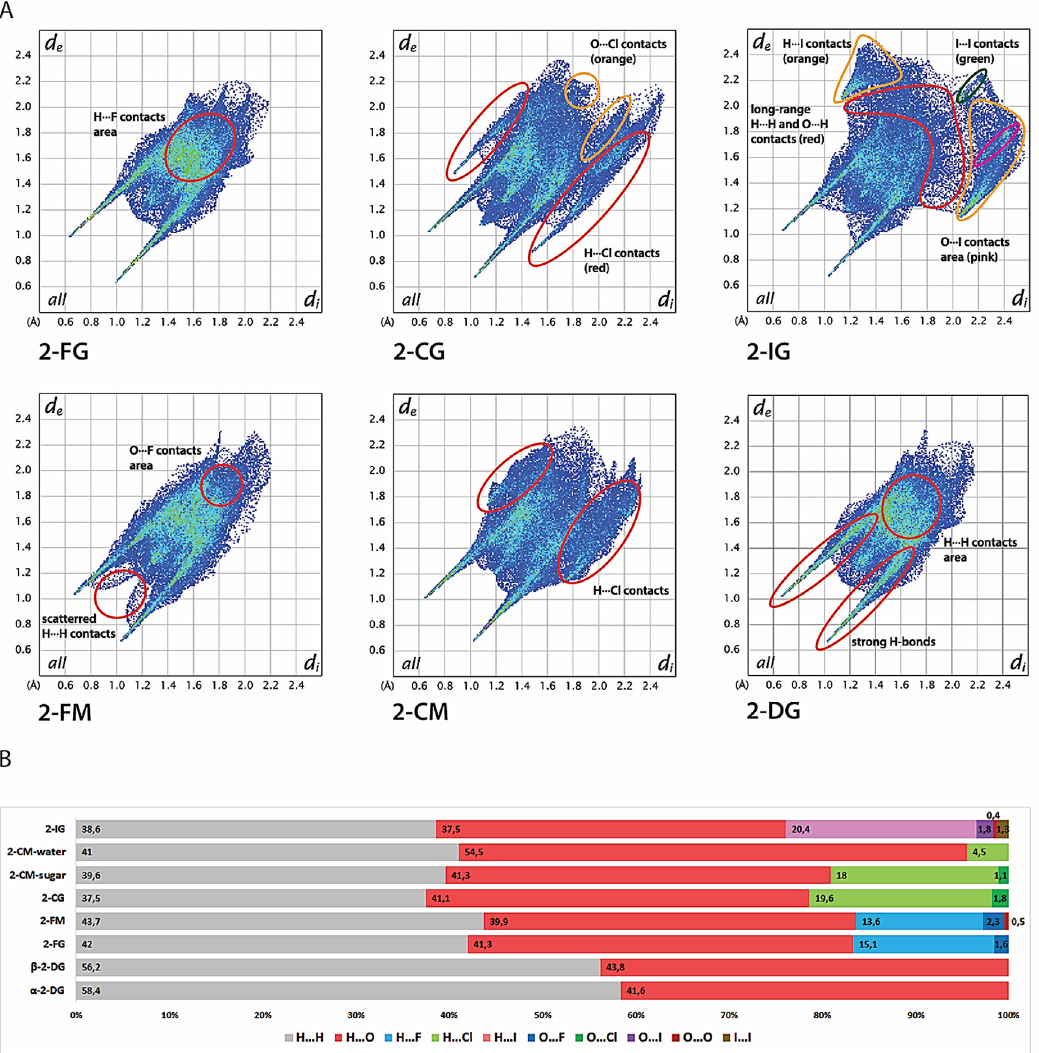
Figure 5. Hirshfeld analysis of the crystal structures. ( A ) Two-dimensional fingerprint plots for the analysed crystals. ( B ) Contribution of each type of interatom contact to the overall Hirshfeld surface for each crystal lattice.